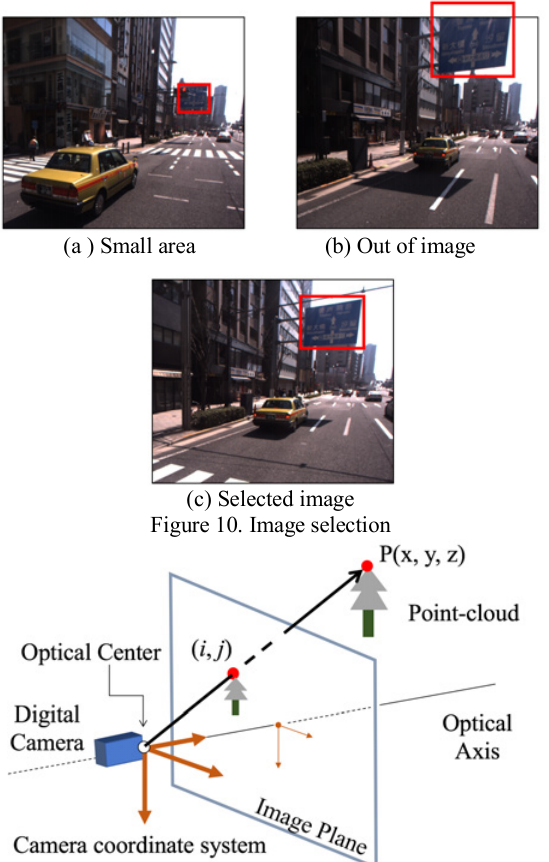
Figure 11. Projection of 3D points on an image